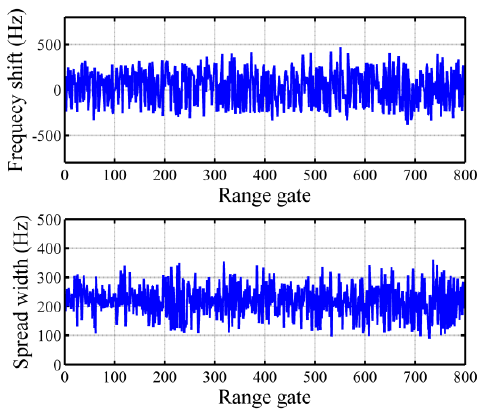
Figure 11. The Doppler centroid and root mean square bandwidth of the Doppler spectrum. For the backscattering coefficient of sea clutter which belongs to the different range gates in the same set of the clutter data, there exists a large difference among the differ- ent range gates in the condition of the low grazing angle which according to the scatter- ing coefficient model of sea clutter [24,25]. According to Equation (14), there is also a